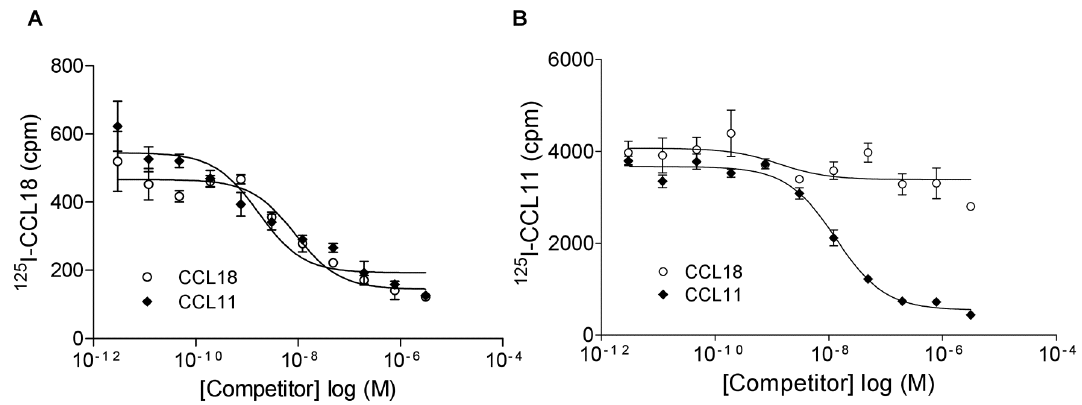
Figure 2. CCL18 does not compete CCL11 for CCR3 binding. Equilibrium competition binding assay using L1.2/CCR3 transfectants. A) Binding of 125 I-CCL18 was competed by an increasing concentration of CCL18 (IC 1.69 nM). One representative experiment out of four is shown. B) 125 I-CCL11 binding was competed by an increasing concentration of CCL11 (IC : 13.2 nM), whereas only a partial displacement was obtained in the presence of CCL18. One representative 50 experiment out of two is shown. Data points are in triplicate and are expressed as mean ± SEM. doi: